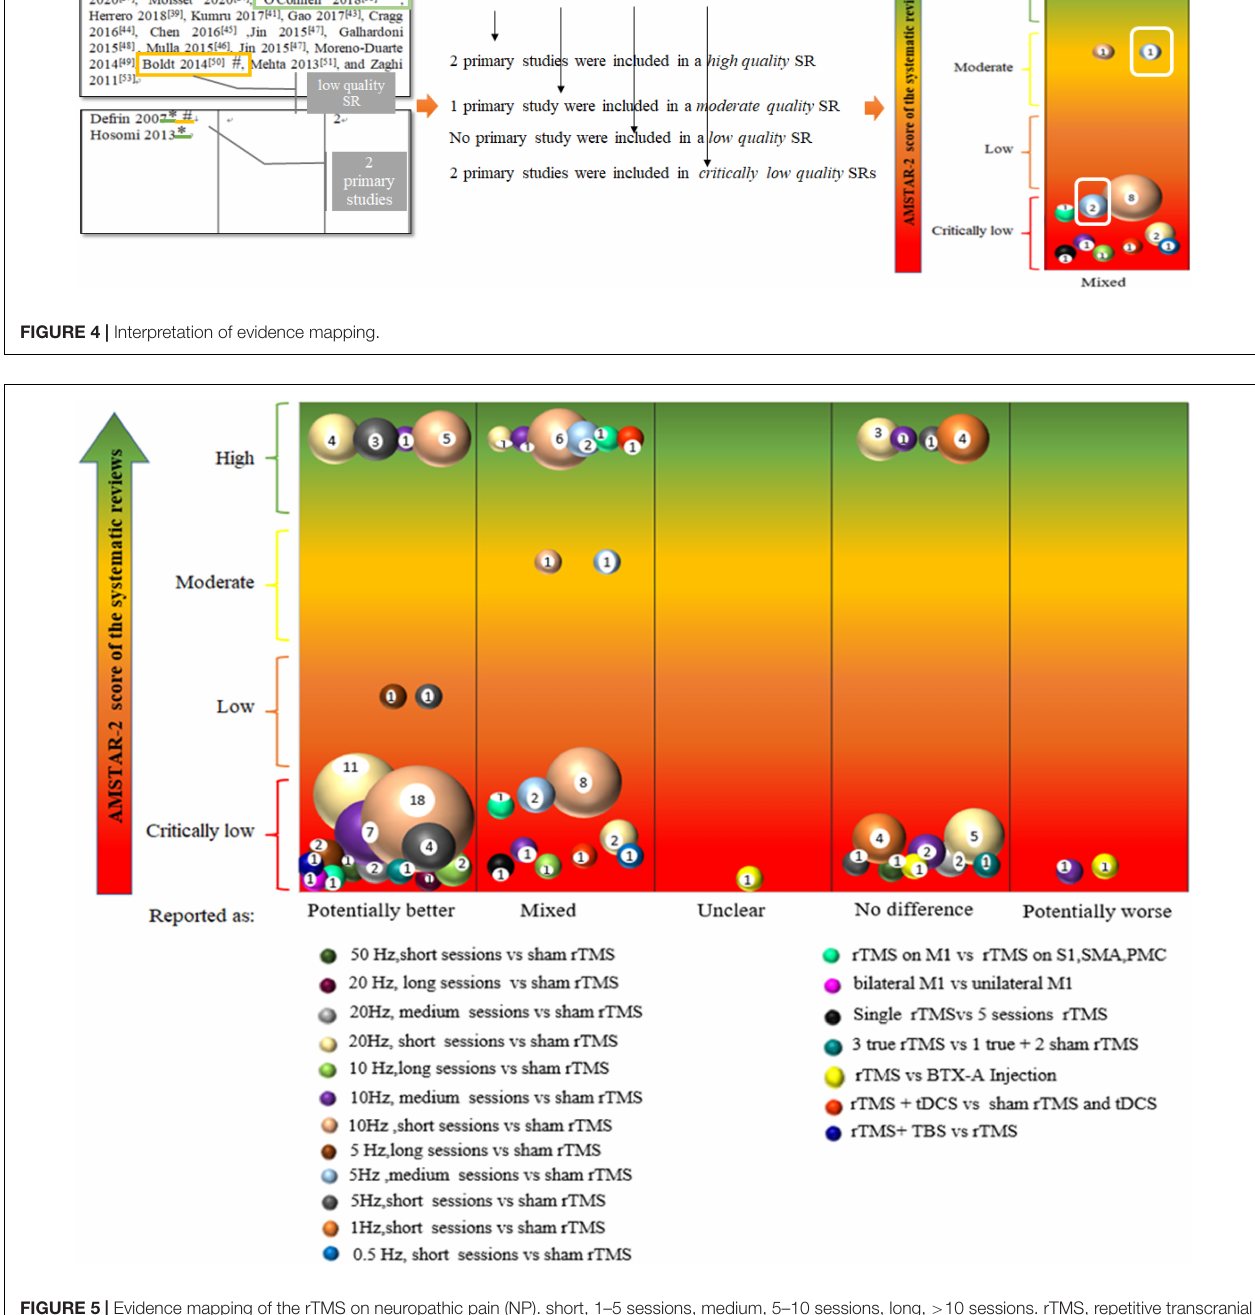
FIGURE 5 | Evidence mapping of the rTMS on neuropathic pain (NP). short, 1–5 sessions, medium, 5–10 sessions, long, > 10 sessions. rTMS, repetitive transcranial magnetic stimulation; tDCS, transcranial direct current stimulation; TBS, theta-burst stimulation; M1,motor cortex, S1, primary somatosensory cortex;